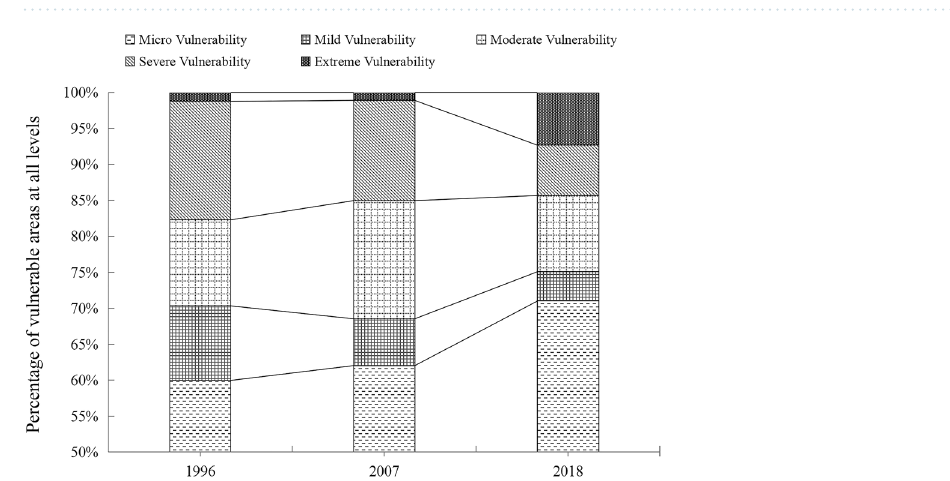
Figure 3. Spatial and temporal distribution of ecological vulnerability in Shennongjia. Spatial and temporal distribution of ecological vulnerability for ( a ) 1996, ( b ) 2007, ( c ) 2018 in Shennongjia, China.